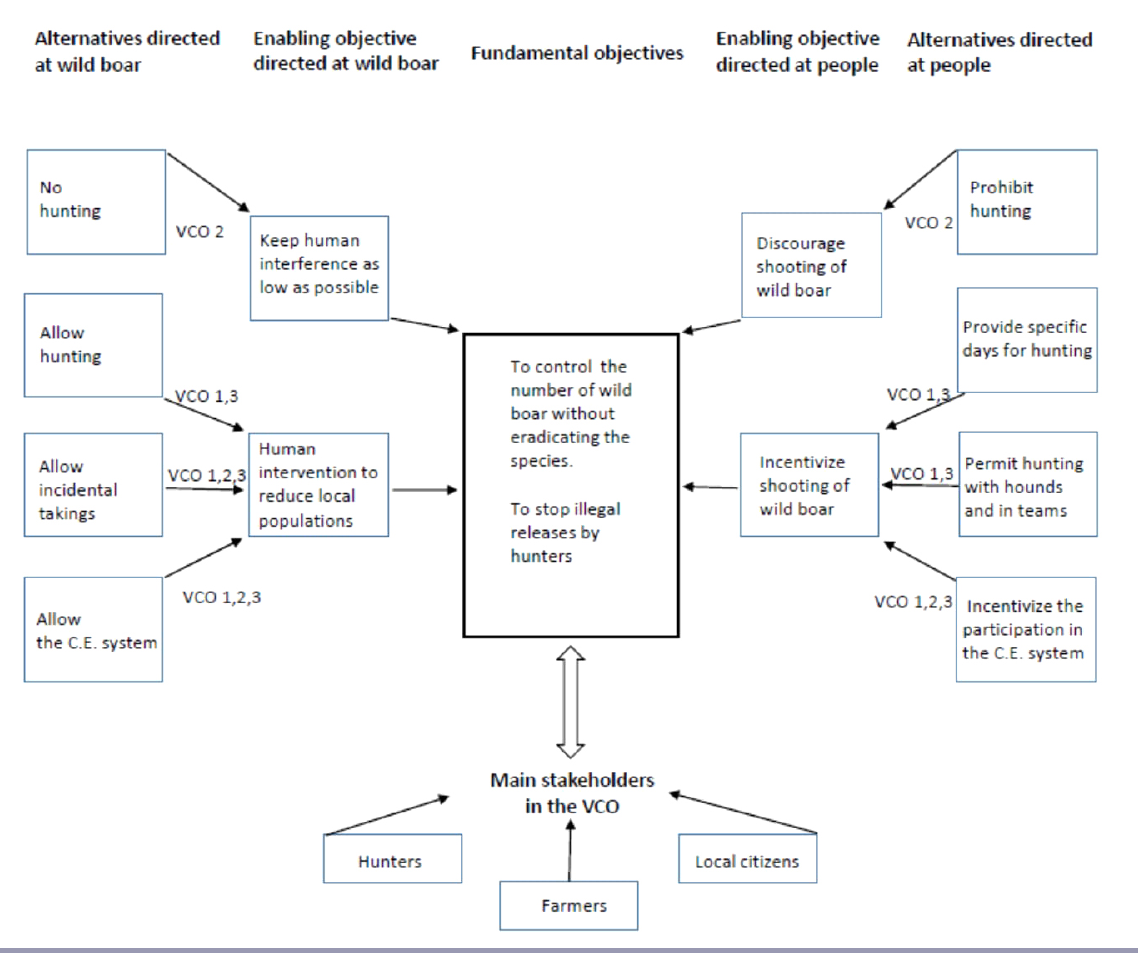
Fig. 2. Means-end linkage diagram applied to the Verbano-Cusio-Ossola (VCO) province hunting districts. The diagram is inspired by Decker et al.